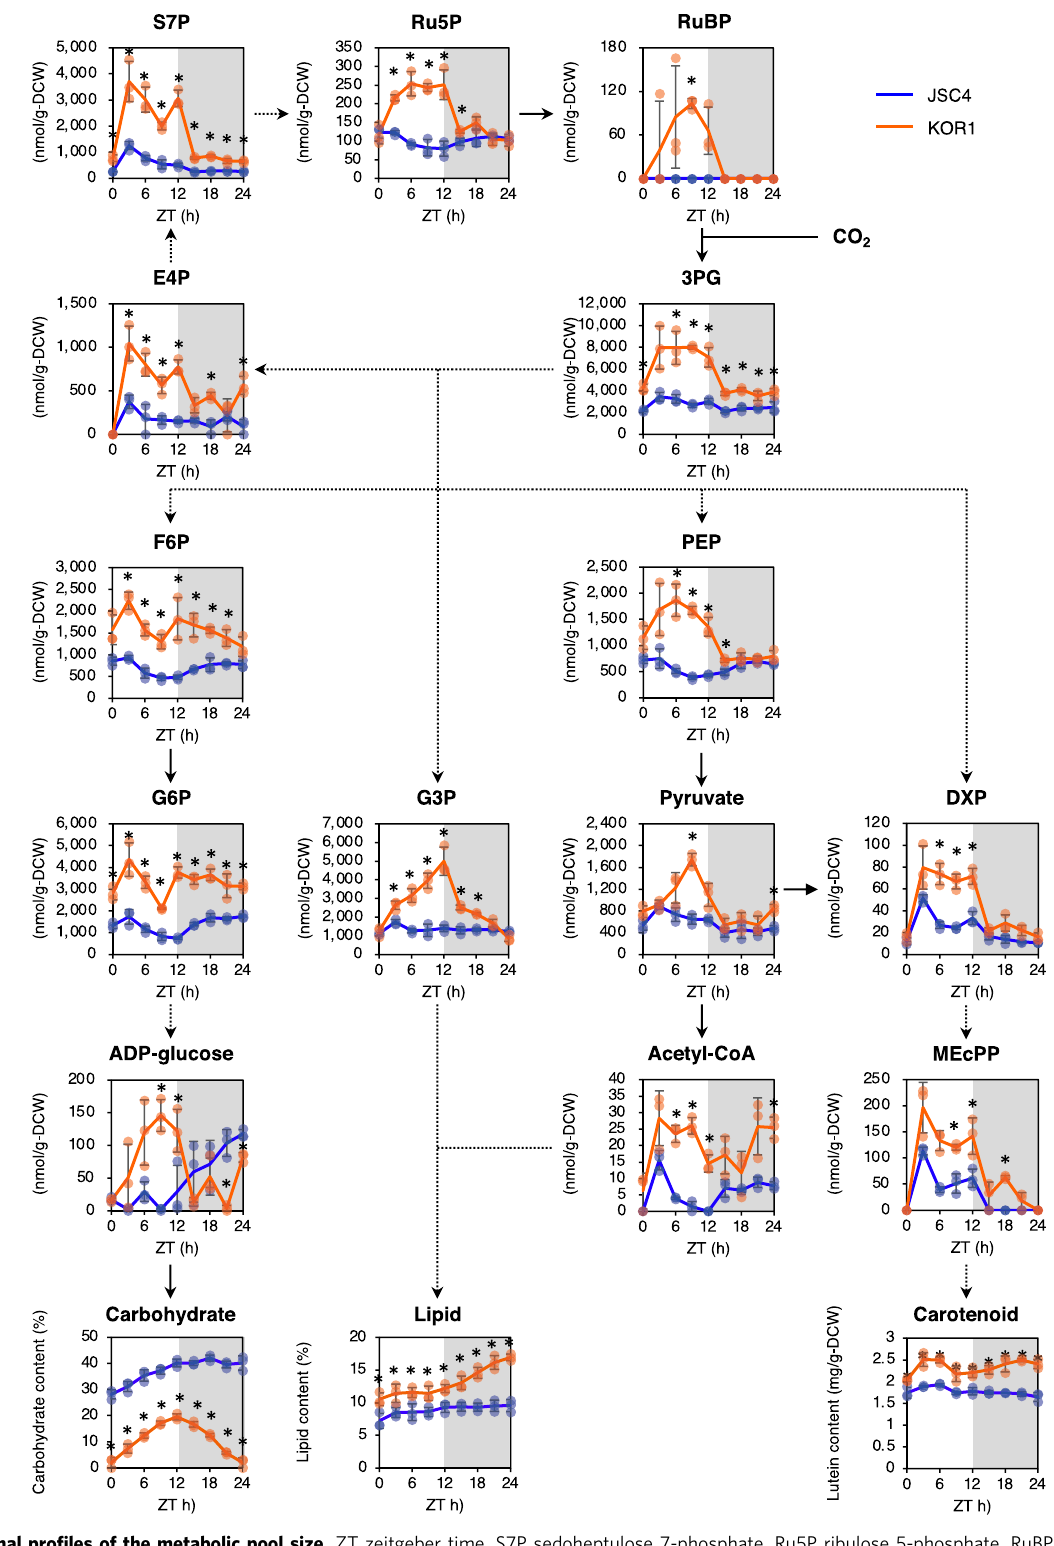
Fig. 5 Diurnal pro fi les of the metabolic pool size. ZT zeitgeber time, S7P sedoheptulose 7 ‐ phosphate, Ru5P ribulose 5 ‐ phosphate, RuBP ribulose-1,5- bisphosphate, 3PG 3 ‐ phosphoglycerate, E4P erythrose 4-phosphate, F6P fructose 6 ‐ phosphate, G6P glucose 6 ‐ phosphate, G3P glycerol 3 ‐ phosphate, PEP phosphoenolpyruvate, DXP 1-deoxy- D -xylulose 5-phosphate, MEcPP 2-C-methyl- D -erythritol-2,4-cyclopyrophosphate. Reactions containing single and multiple enzymatic steps are represented by solid and dotted lines, respectively. White and gray bands represent light and dark periods, respectively. Error bars indicate the standard deviation of three replicate experiments (* p < 0.05 by Welch ’ s t